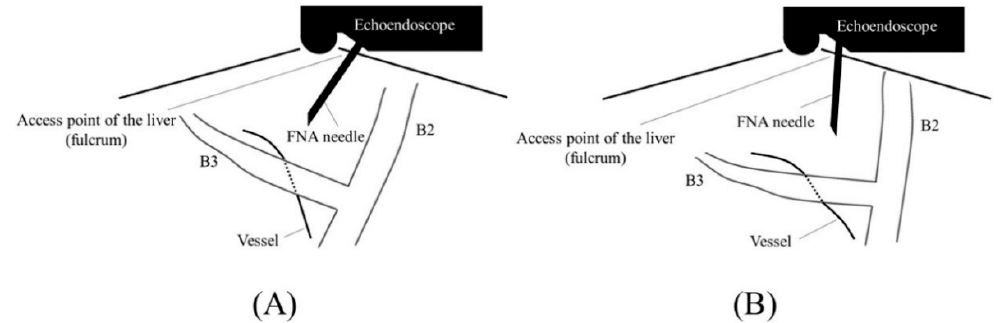
Figure 9. Changing a needle trajectory during biliary puncture. If a favorable biliary puncture line cannot be obtained due to the intervening vessels ( A ), pushing a scope after advancing a needle into the liver parenchyma to change the needle direction using the liver access point as a fulcrum ( B ).